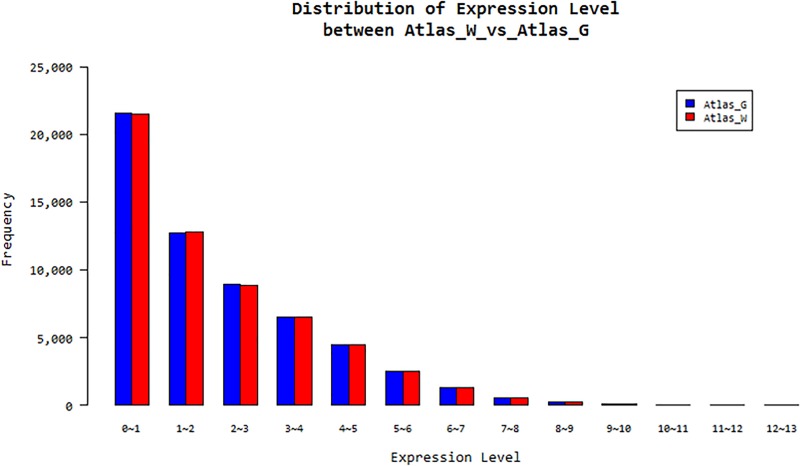
Distribution of expression levels between Atlas_G of green shoot asparagus and Atlas_W of white shoot asparagus.